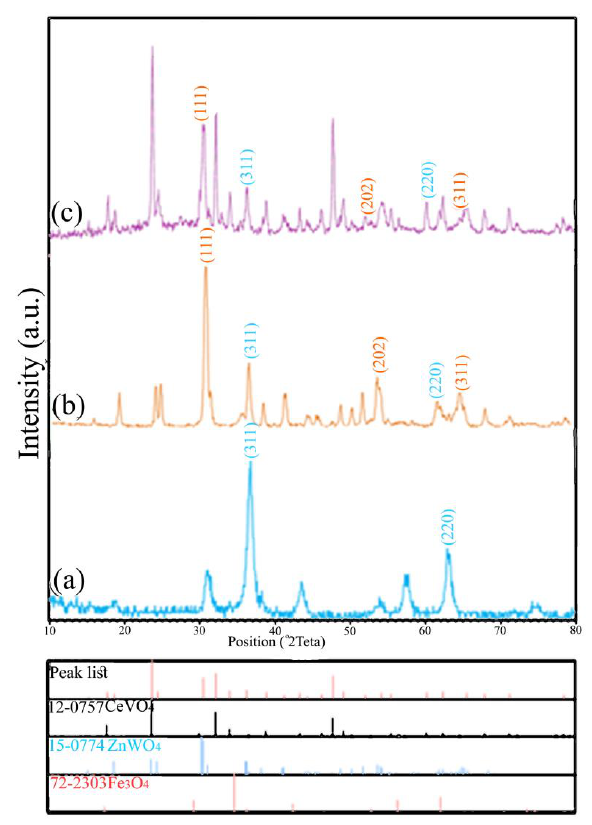
Figure 1. XRD patterns of ( a ) Fe 3 O 4 , ( b ) Fe 3 O 4 / ZnWO 4 (S 1 ), and ( c ) Fe 3 O 4 / ZnWO 4 / CeVO 4 (S 4 ).